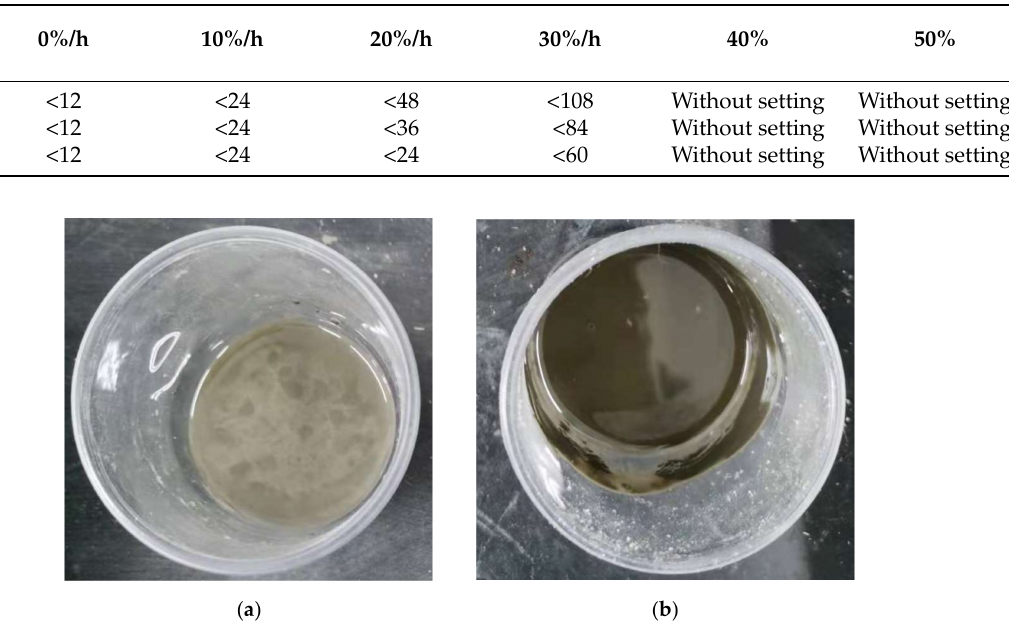
Table 4. Effect of PEG-600 dosage and water–cement ratio on setting time of cement matrix.